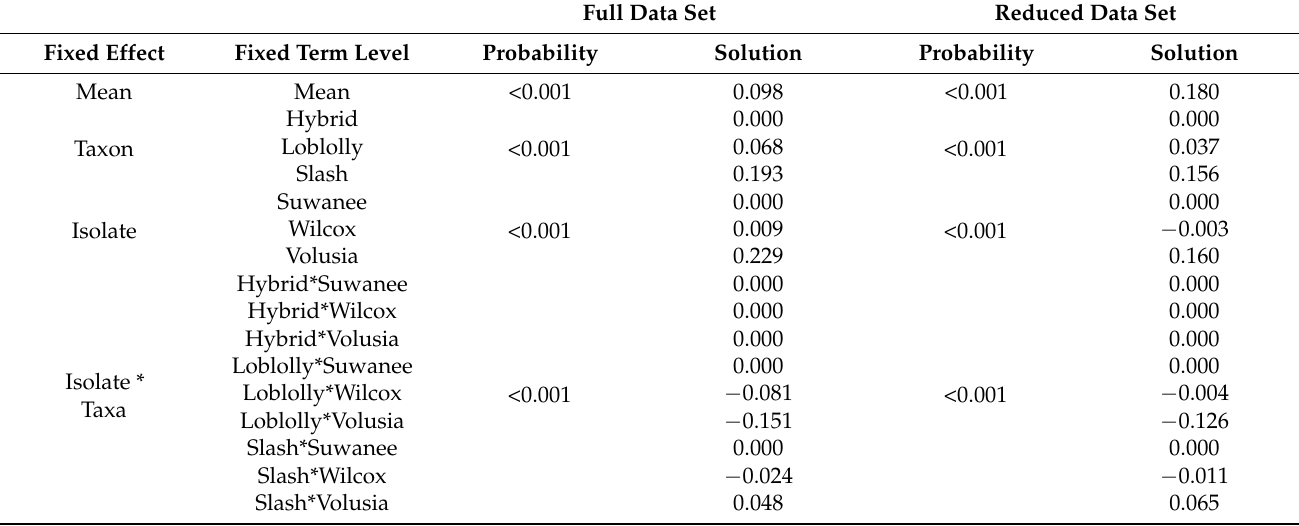
Table 2. Solutions for fixed effects from the model including all data and data with potential escapes excluded. Solutions indicate the predicted addition or subtraction of the predicted damage ratio. P-scores were functionally equivalent for fixed terms in each model, with every term including the replication–isolate nested interaction, a blocking effect, significant at p <